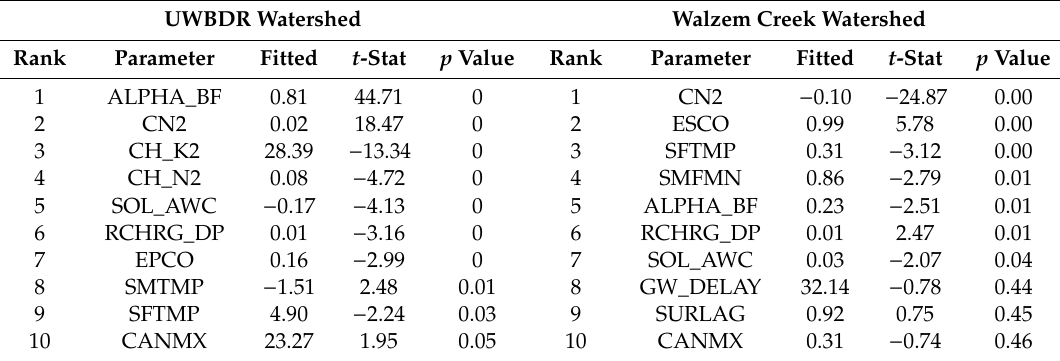
Table 2. Top 10 optimized SWAT sensitive parameter values in the UWBDR watershed and Walzem Creek